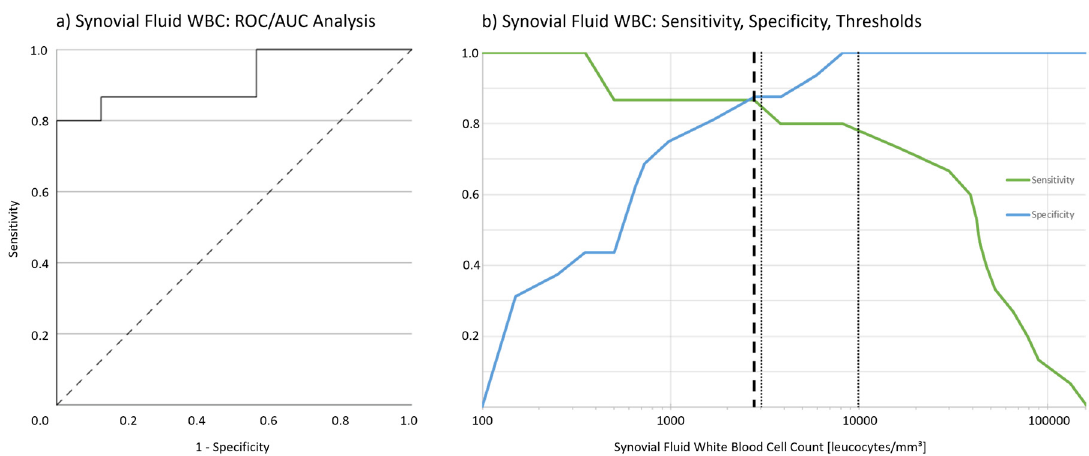
Figure 2. ( a ) ROC/AUC analysis for the sensitivity and specificity of synovial white blood cell count (WBC) in PSI. 2800 leucocytes/mm 3 showed a sensitivity of 87% and a specificity of 88% (AUROC 0.92, Youden index 0.74). ( b ) Sensitivity and specificity of synovial white blood cell count in the diagnosis of PSI (according to IDSA criteria). WBC was plotted in decadic logarithmic scaling. The dashed vertical line represents the calculated threshold for PSI (2800 leucocytes/mm 3 ). Dotted vertical lines represent WBC thresholds for chronic (3000 leucocytes/mm 3 ) and acute (10,000 leucocytes/mm 3 ) periprosthetic hip and knee infections according to ICM criteria.